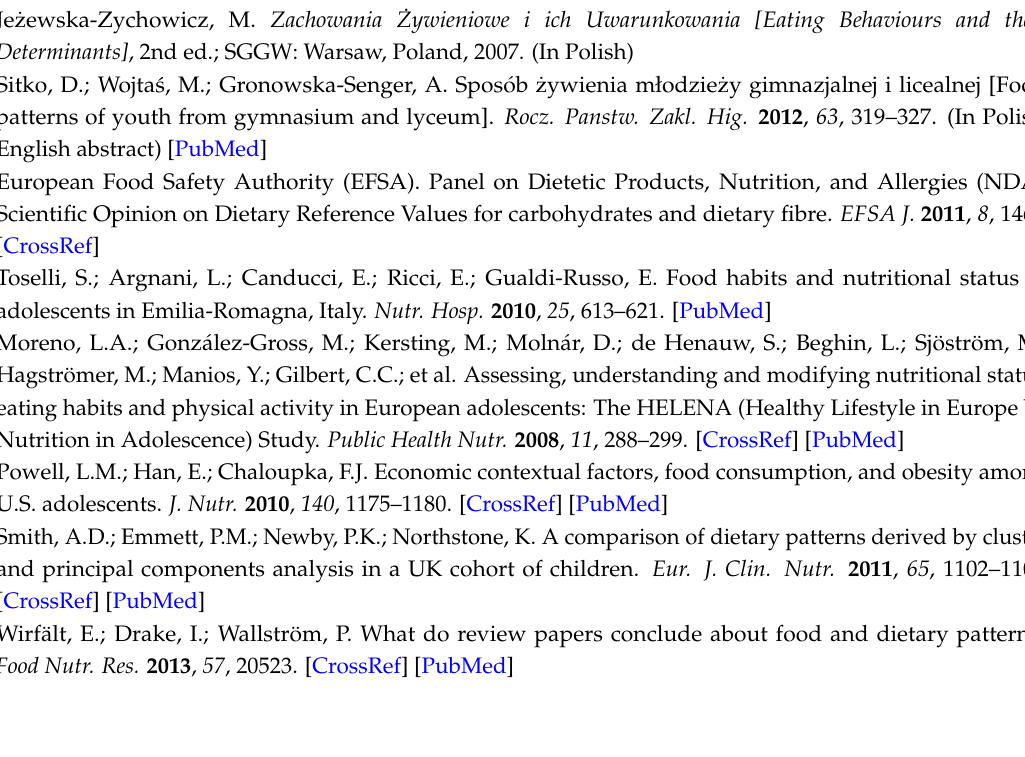
Figure S1: Flow chart of sample collection and study design, Table S1: Single factors of socioeconomic status by socioeconomic status categories in Polish adolescents, Table S2: Socioeconomic status and its single factors and frequency consumption of dietary fibre sources in Polish boys and girls, Table S3: The frequency (in points) of fibre intake and its dietary sources by socioeconomic status and fibre dietary patterns in Polish adolescents (mean with 95% confidence